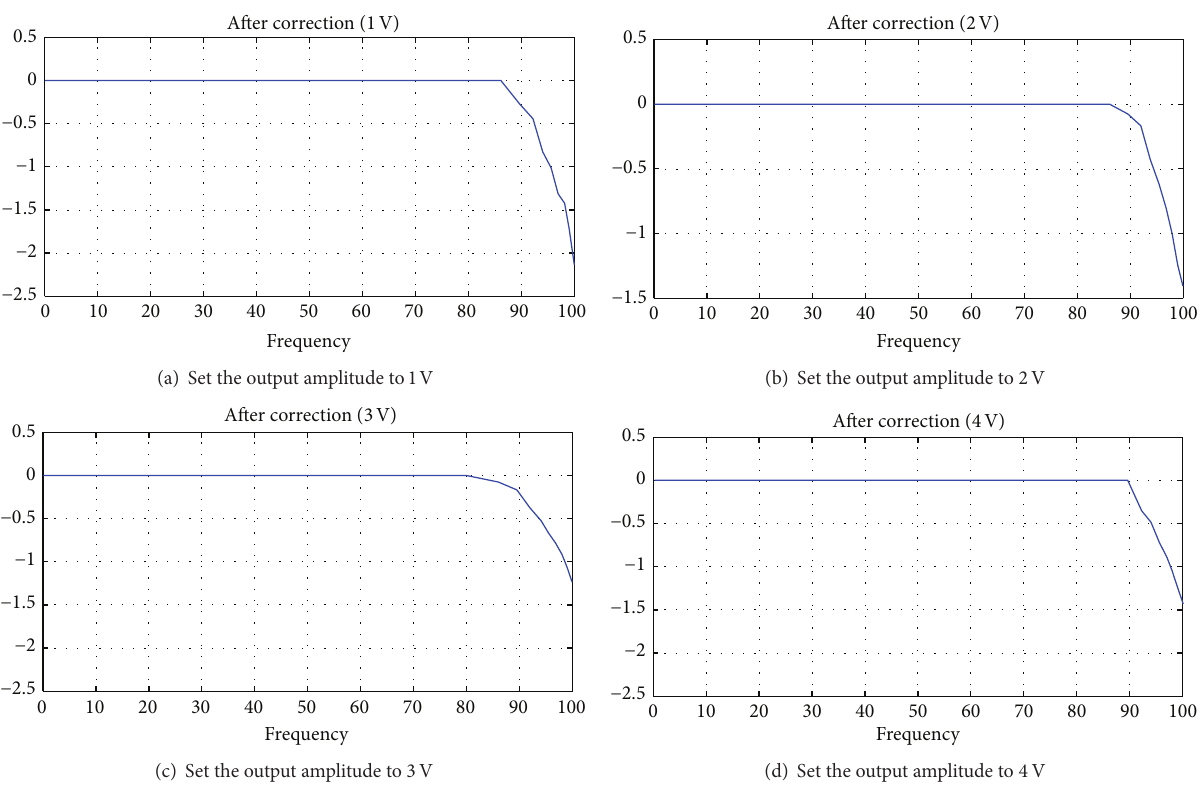
Figure 25: Amplitude